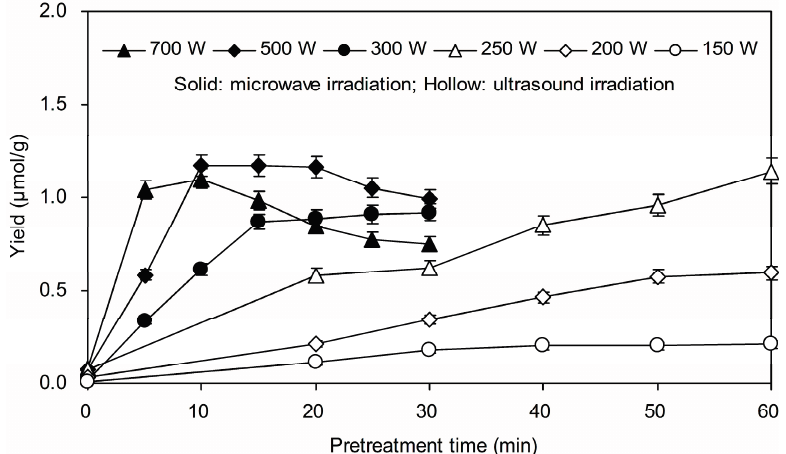
Figure 1. Effect of microwave and ultrasound irradiation power on yield of genipin. One gram degreased sample powder was added into 10 mL deionized water and homogeneous mixing prepared for pretreatment by microwave or ultrasound at different irradiation power. The samples were then mixed with 5.0 mg cellulase, and subsequently the mixtures were incubated at 40 °C for 24 h. After incubation, 10 mL ethanol was added to extract genipin over 30 min.